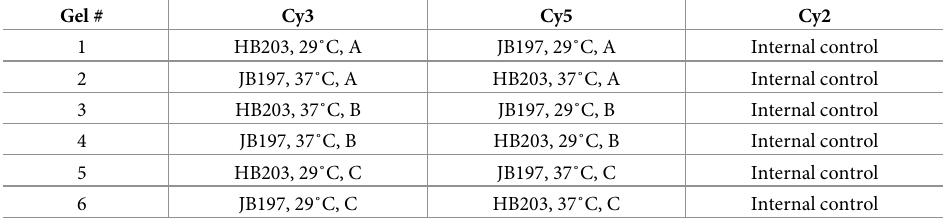
Table 1. Experimental design for DIGE experiment. Three replicates (A, B & C) of L . borgpetersenii serovar Hardjo strain HB203 and JB197, cultured at 29 or 37˚C, were labeled with Cy3 or Cy5. An internal control comprising an equal amount of all 12 replicates was labeled with